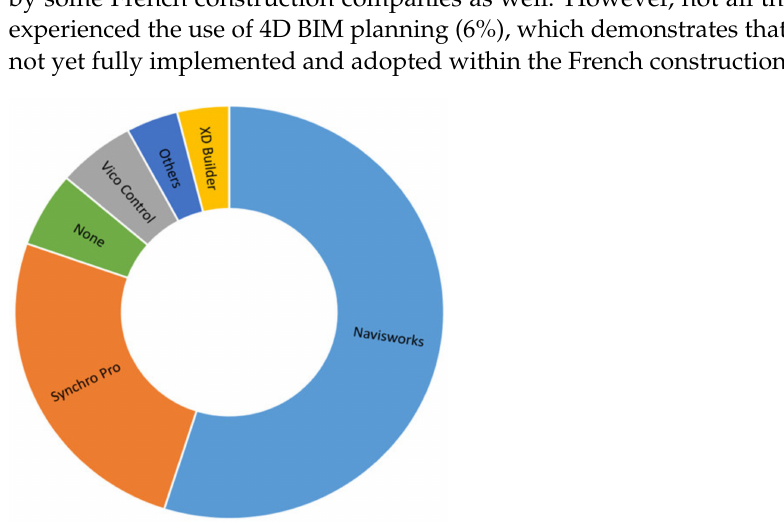
Figure 2. Most used 4D BIM tools in